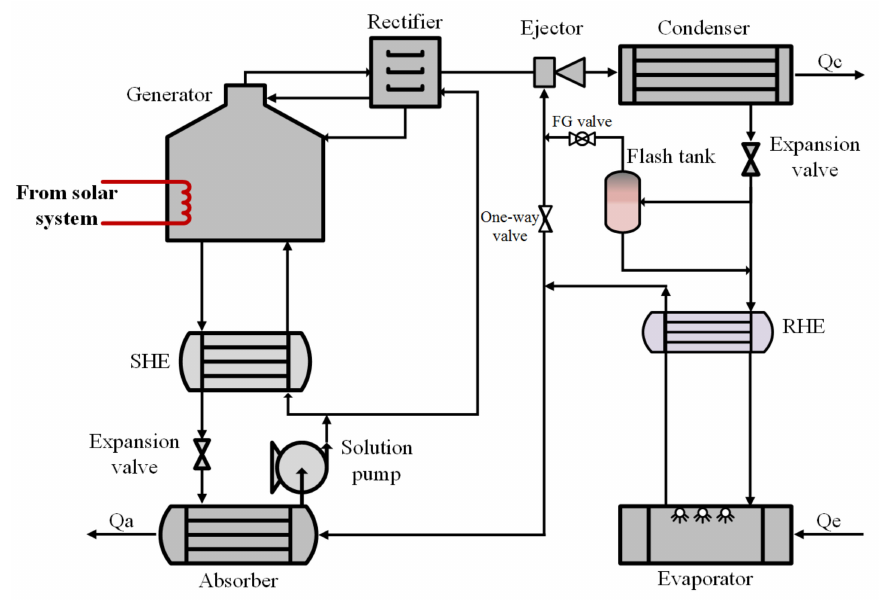
Figure 8. Schematic of HEARS with flash tank and RHE